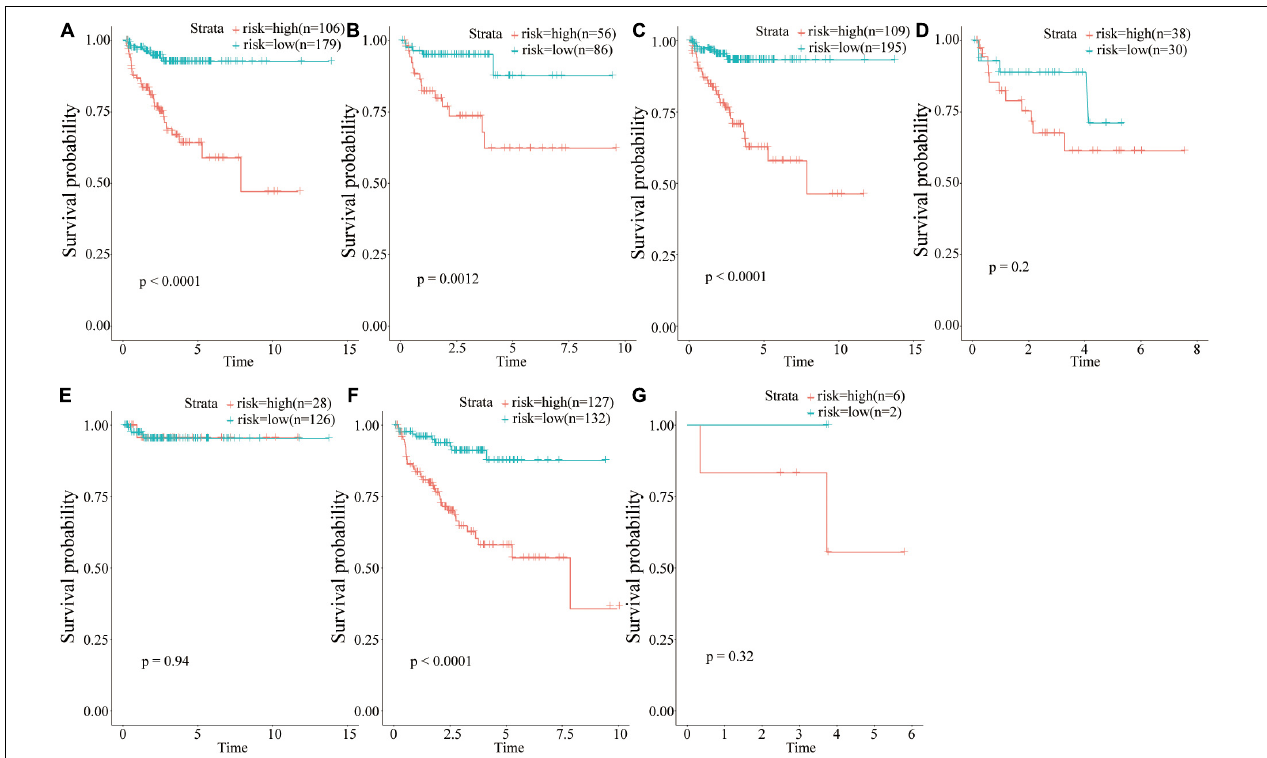
FIGURE 6 | Group analysis of the prognostic value of risk scores. (A) < 65 years age group; (B) ≥ 65 years age group; (C) N0 group; (D) N1 group; (E) T2 group; (F) T3 group; (G) T4 group.